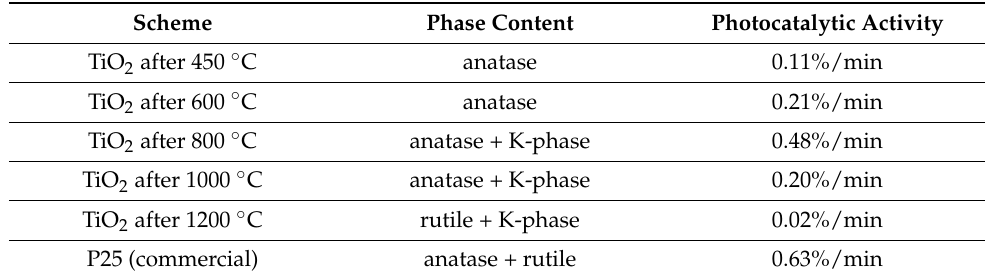
Table 1. Phase content and photoactivity under UV of the obtained powders and commercial TiO 2 .